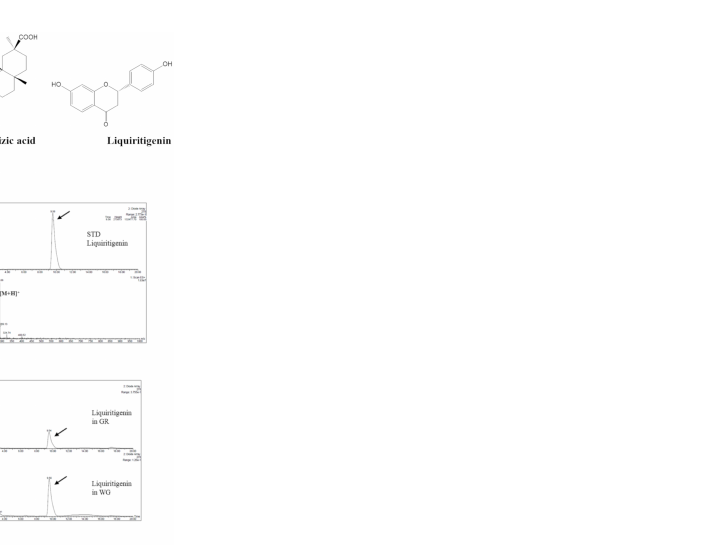
Figure 1. Chemical analysis of glycyrrhizic acid (GA) and liquiritigenin in Wongam (WG) and gly- cyrrhizae radix (GR): ( a ) chemical structures of GA and liquiritigenin; ( b ) HPLC chromatogram and mass fragmentation pattern of GA and liquiritigenin; ( c ) HPLC chromatogram of WG and GR extracts.